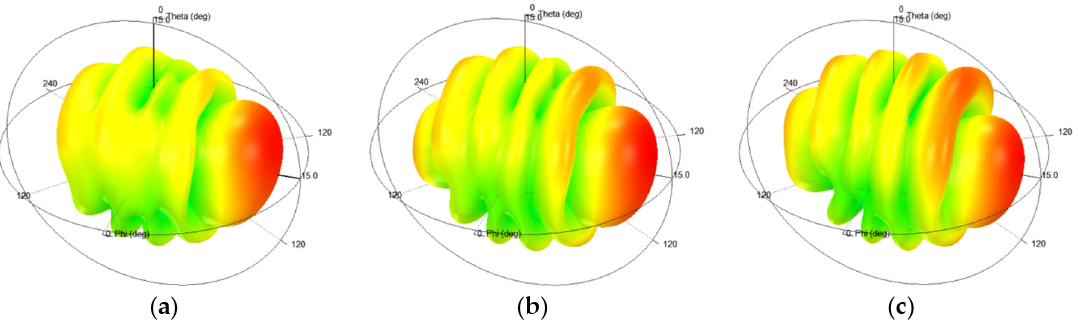
Figure 7. The 3D radiation patterns of the proposed antenna at different frequencies: ( a ) 5.8 GHz; ( b ) 6 GHz; ( c ) 6.2 GHz.